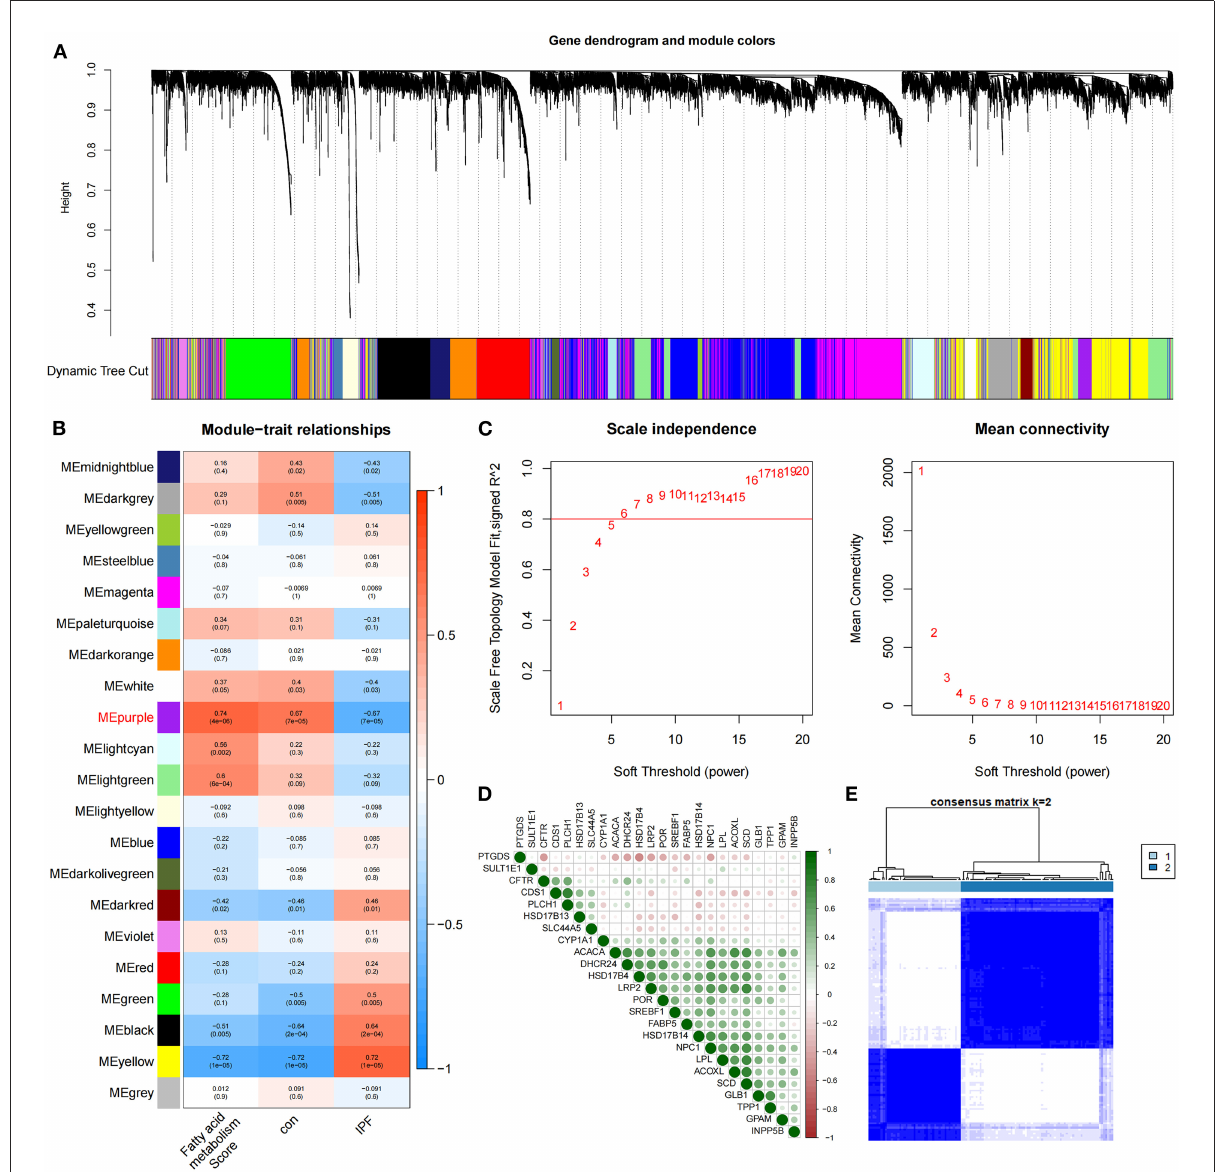
FIGURE1 Identification of core FAMRGs in IPF. (A) WGCNA analysis was performed on the training set to obtain the cluster tree of co-expressed genes. (B) Construct module-trait relationships, with each module containing the corresponding correlation and P -value. (C) Soft threshold of scale-free network. (D) The interaction of 24 core FAMRGs. (E) Heatmap of the matrix of co-occurrence information for IPF samples.